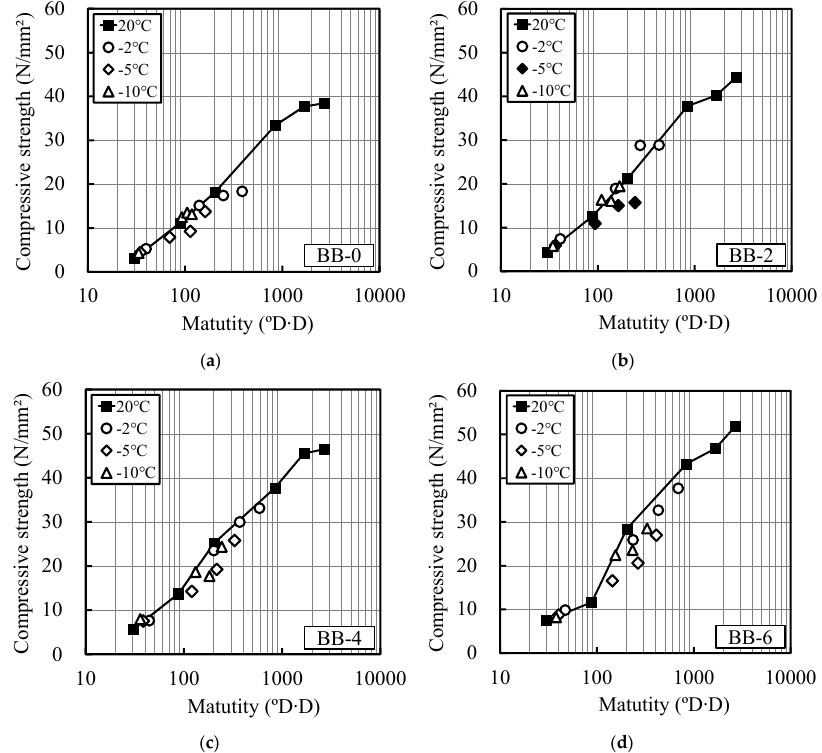
Figure 10. Relation between maturity and compressive strength (BB): Proposal equation for this study, ( a )BB-0;( b )BB-2;( c )BB-4;( d )BB-6. The relationships between maturity and compressive strength for OPC and BB, calculated using Equations (12) and (13) in this study, are shown in Figures 9 and 10, respectively. OPC-0 and BB-0, in which the antifreezing admixture was not added, satisfied x = 0. Thus, it is the same equation as the existing Equation (2). When the antifreezing admixture was added, the strength development of mortar could be expressed accurately by using the maturity given in Equation (13), as verified by the figures.